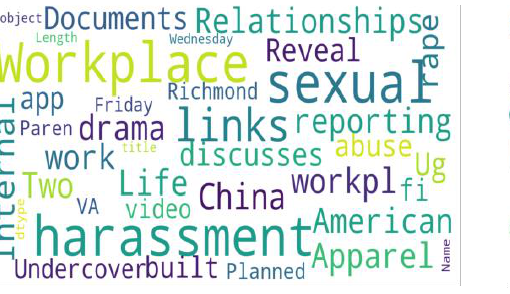
Figure 3 . Word Cloud analysis for our Reddit